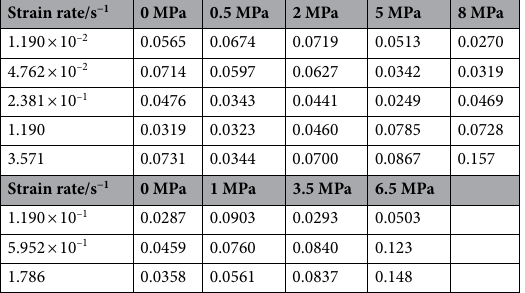
Table 4. The values of RMSE under various experimental